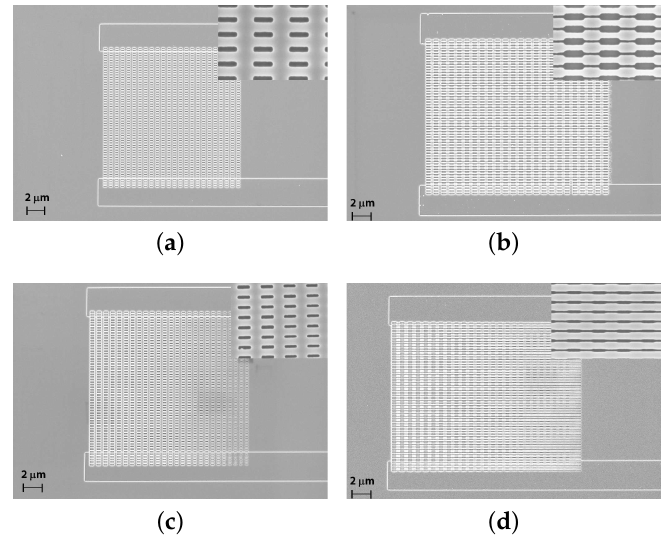
Figure 7. Scanning electron microscope (SEM) image of four different kinds of SWG couplers fabricated on SOI (inset shows magnified image). ( a ) Uniform Si - SWG ; ( b ) Uniform dual - SWG ; ( c ) Non-uniform Si - SWG and ( d ) Non-uniform dual - SWG